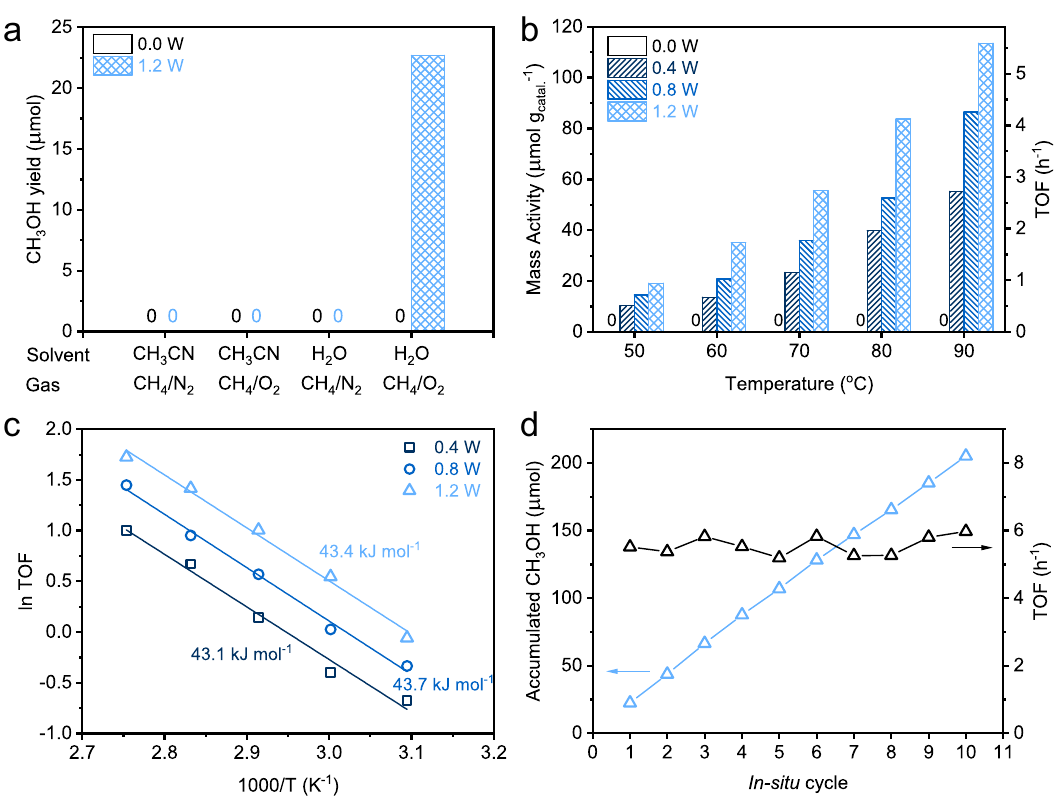
Fig. 2 Catalytic performance of Au 1 /BP nanosheets in partial oxidation of methane. a Comparison of methanol yields under different solvents and reactants at 90°C for 2 h. b Mass activities and TOF numbers in 20 mL of water under 33 bar (CH 4 :O 2 = 10:1) at different temperatures under different light powers with an irradiation area of 3.14 cm 2 . c The Arrhenius plots of Au 1 /BP nanosheets under different light intensities. d Products and TOF numbers obtained by conducting in situ cycles. For each cycle, the catalytic reaction was operated under 33 bar (CH 4 :O 2 = 10:1) at 90°C for 2 h (1.2